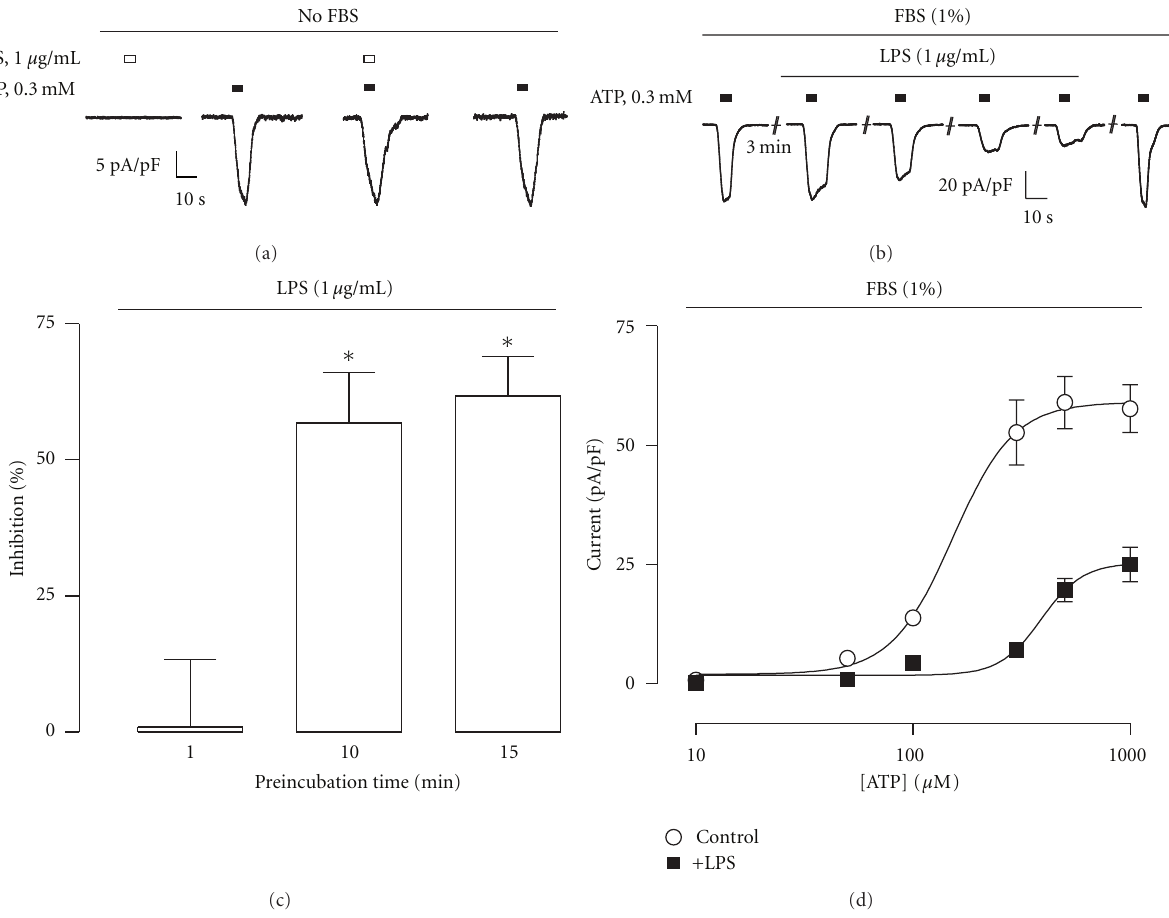
Figure 1: LPS inhibits ATP-induced currents in P2X7R-HEK293 cells. (a) LPS alone (1 μ g/mL) does not gate currents nor inhibit 300 μ M ATP-gated currents when coapplied. Data are representative of 5-6 independent experiments, in the absence of FBS. (b) Representative experiment of the LPS-induced inhibition of ATP-evoked currents. The e ff ect of LPS is time-dependent, experiments were run in the presence of 1% FBS. (c) Summary of the e ff ect of LPS on ATP-evoked currents after 1, 10, and 15min of preapplication ( n = 6–8, P < 0 . 05, Kruskal- Wallis test). (d) ATP concentration-response curves in the absence (open circles) or in the presence of 1 μ g/mL LPS (closed circles). LPS was added 30min before the start of each experiment ( n =